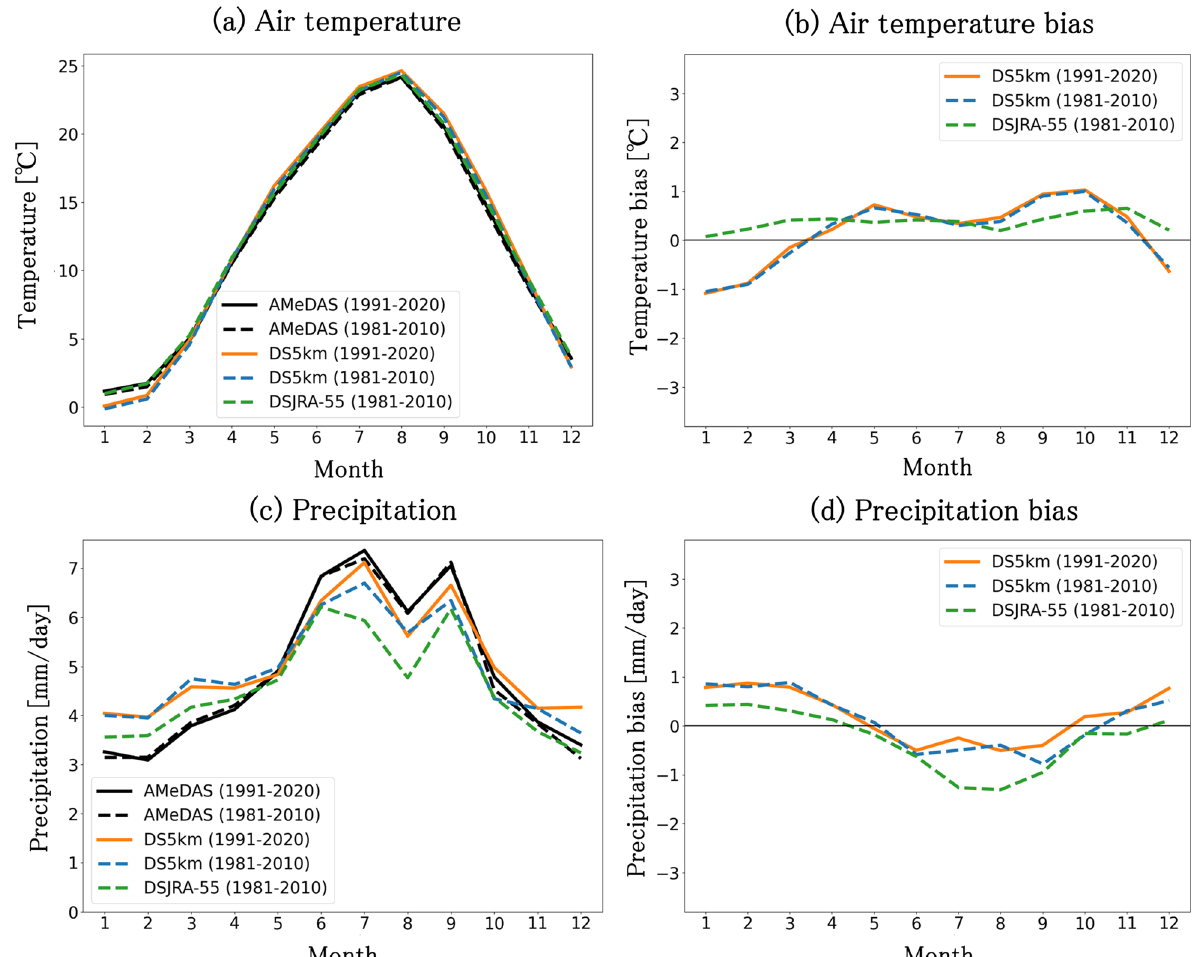
Fig. 3 Monthly mean surface air temperature and monthly precipitation; a mean surface air temperature and their biases; c , d total precipitation and their biases; a , c black and orange lines represent the averages of AMeDAS and DS5km, respectively, between 1991 and 2020. Blue and green lines represent the averages of DS5km and DSJRA‑55, respectively, between 1981 and 2010. b , d Orange, blue, and green lines represent the biases in DS5km (1991–2020), DS5km (1981–2010), and DSJRA‑55 (1981–2010), respectively